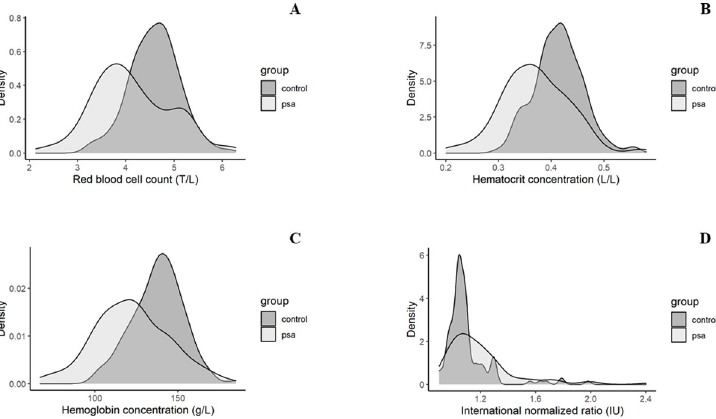
Fig 3. The single effect of red blood cells (A), hematocrit (B), hemoglobin (C), and international normalized ratio (D) on pseudoaneurysm development. Kernel density plots of